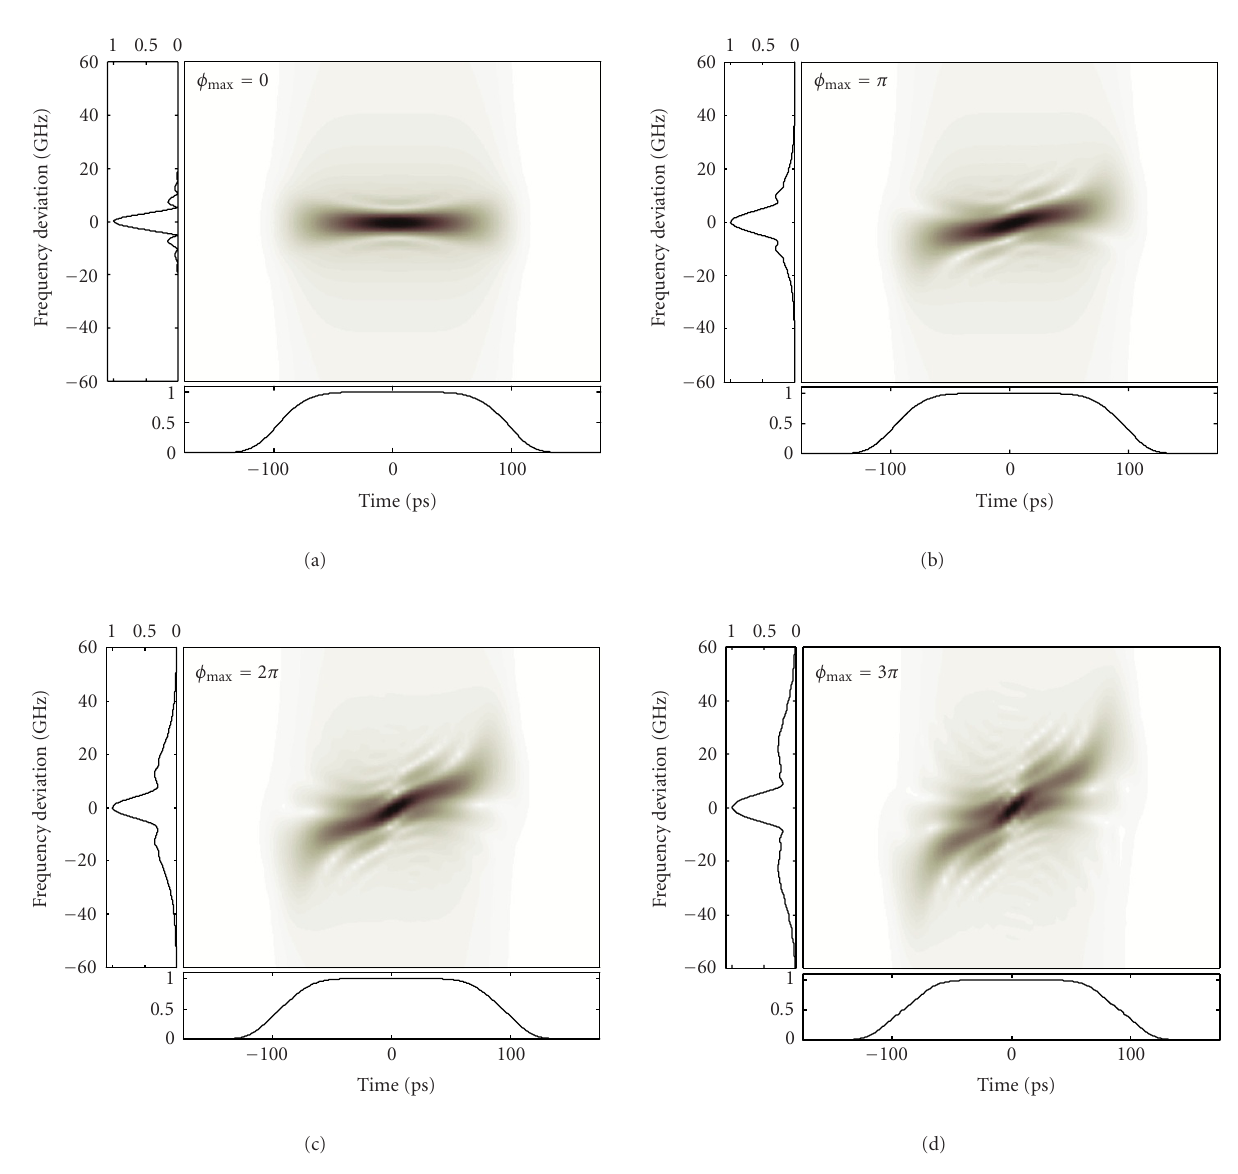
Figure 4: Wigner analysis of pulse self-phase modulation in an optical